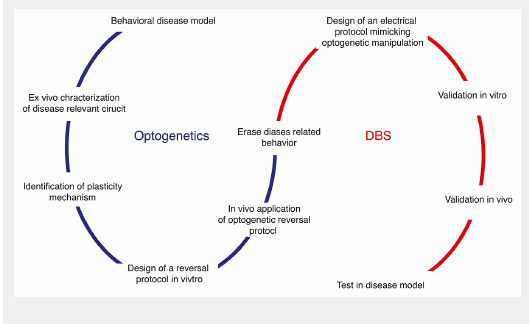
Blueprint of translation of optogenetic approaches into novel protocols of deep brain stimulation (DBS) . Research starts in animal models of the disease and with identification of the relevant circuits. A crucial step is the in vitro emulation of the